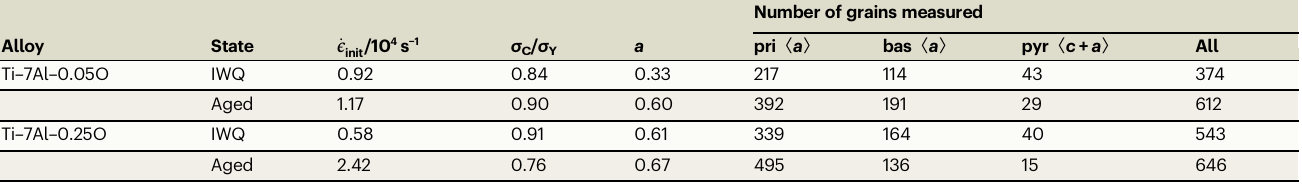
Table 1 | Details of the in situ creep ff-HEDM experiment to investigate time-dependent micromechanics